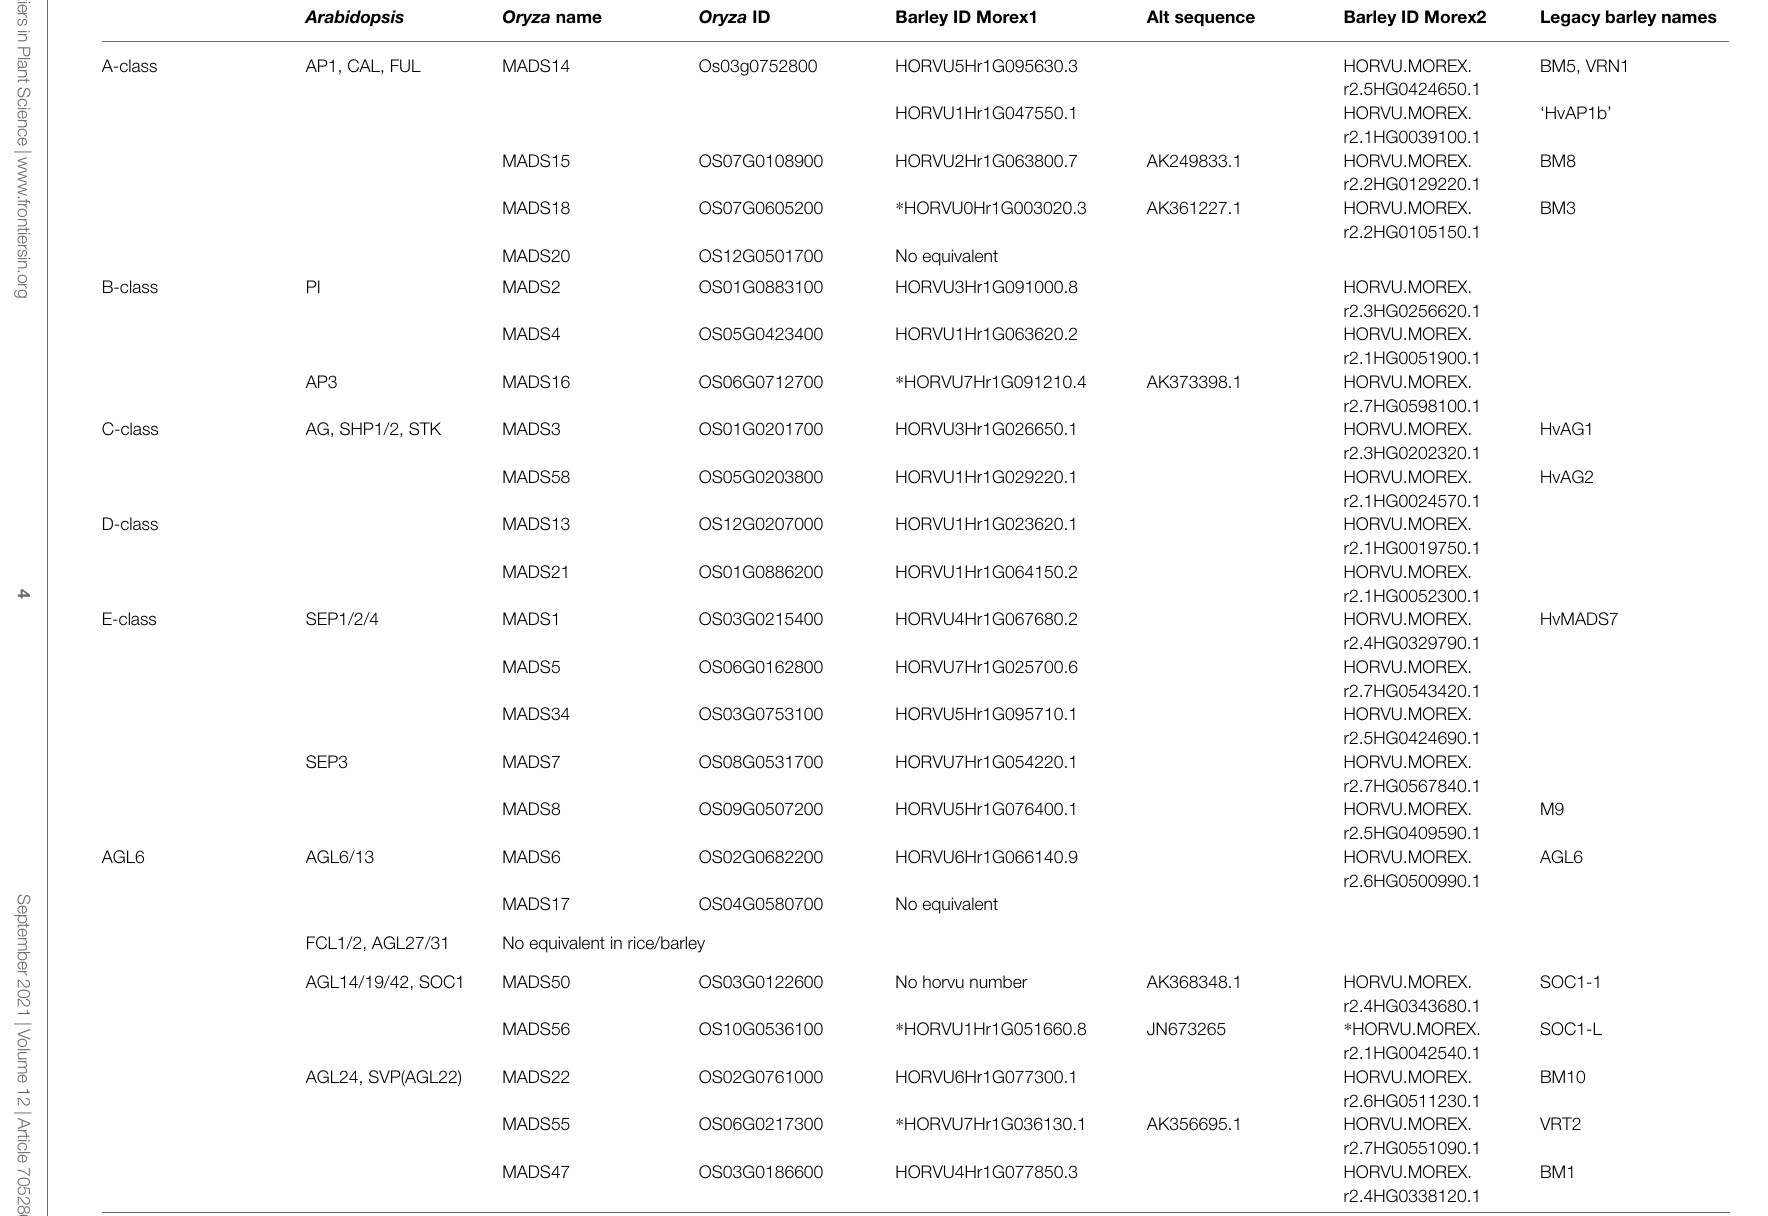
TABLE 1 | The MIKCc MADS-box protein family in barley compared to rice. Arabidopsis Oryza